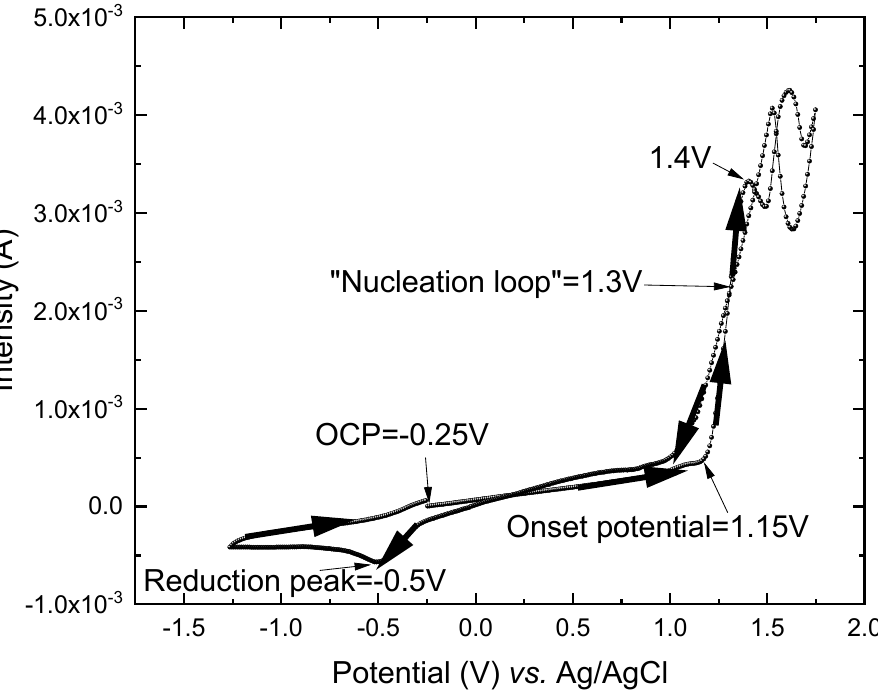
Figure 1. Cyclic voltammetry in acetonitrile of 0.01 M EDOT and 0.1 M LiClO 4 with a scan rate of 0.01 V/s and at room temperature.